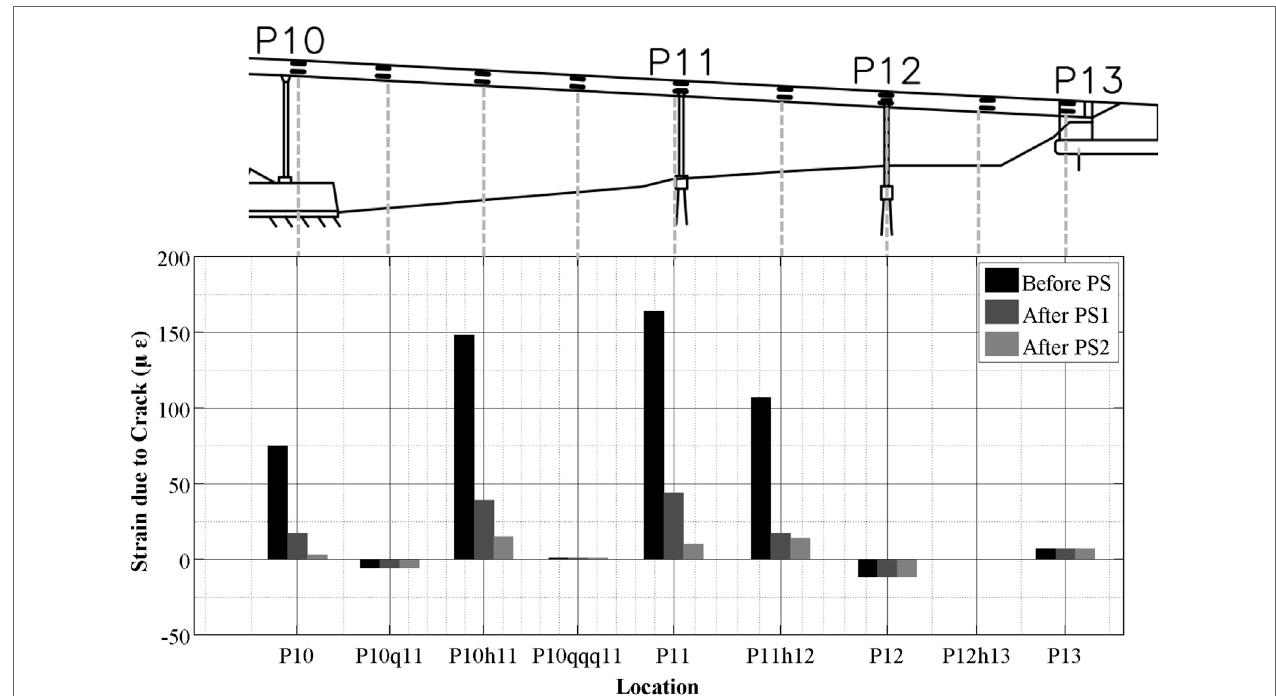
FIGURe 9 | summary of strain due to crack at the centroid of stiffness of all instrumented locations along the southeast leg of streicker Bridge (grayed labels refer to cracked locations) .